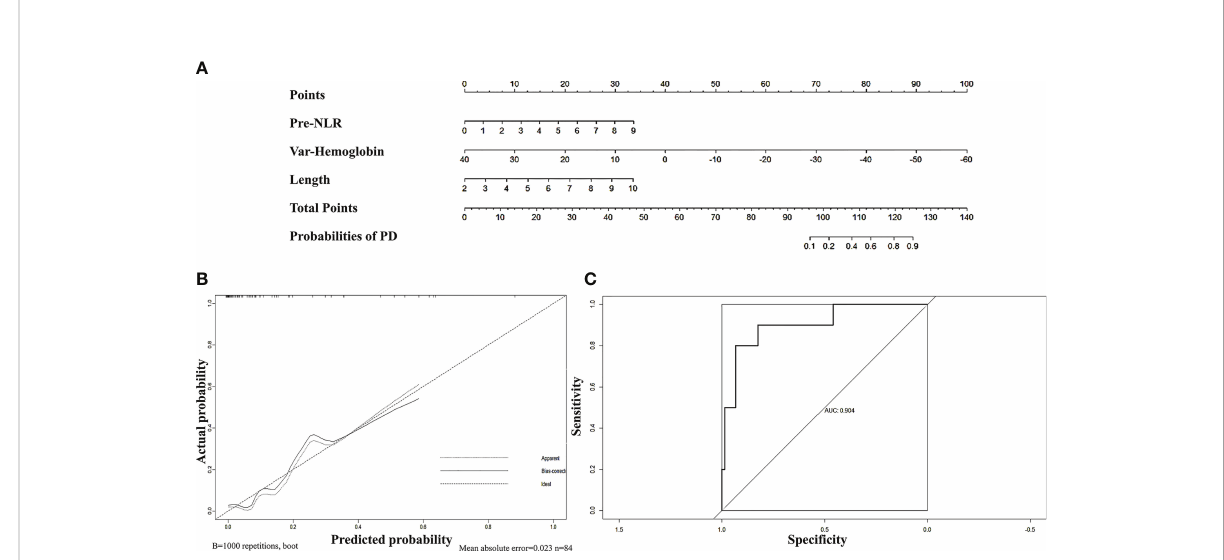
FIGURE 2 (A) Nomogram for predicting PD rates after neoadjuvant chemoradiotherapy in patients with oesophageal squamous cell carcinoma. The nomogram adds up the points identi fi ed on the scale for each independent factor. The total scores projected on the bottom scale indicate the probabilities of PD. (B) Calibration plots of the nomograms. (C) ROC curves of the